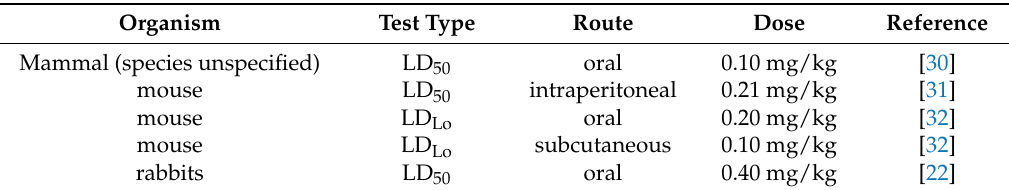
Table 1. Some toxicity parameters of Tetramethylenedisulfotetramine for mammals via different routes of